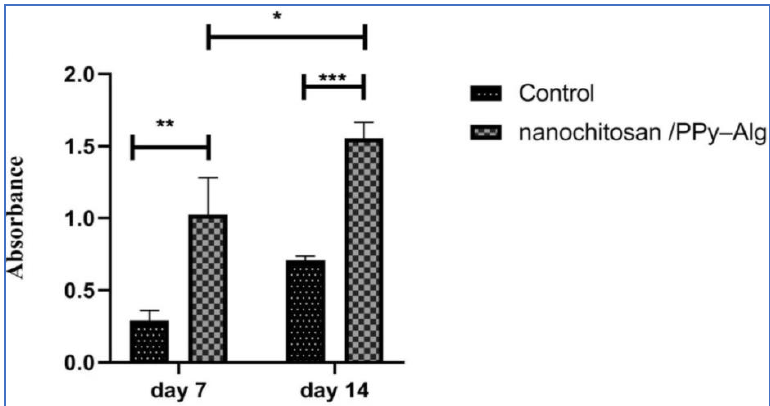
Figure 4. Proliferation of OLN-93 cells cultured on nanochitosan/PPy-Alg scaffold compared to control after 7 and 14 days. *: p < 0.05, **: p < 0.001, and *** p < 0.0001. Adapted with permission [107].